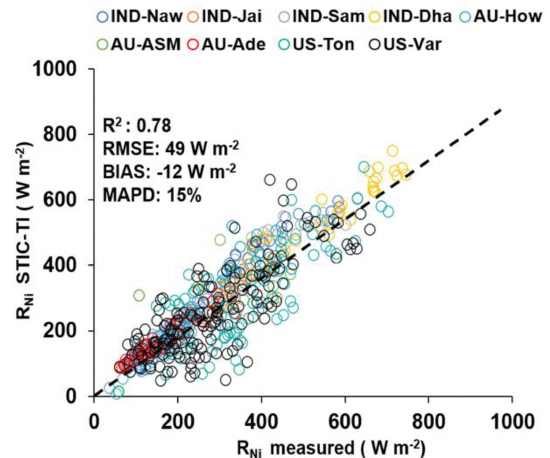
Figure B1. Validation of STIC-TI-derived R Ni estimates with re- spect to in situ measurements in different ecosystems. The regres- sion equation between modeled versus in situ R Ni is R Ni (STIC- TI) = 0 . 78 R Ni (tower) + 58.92. Table B1. Performance evaluation statistics of clear-sky R Ni esti- mates in nine different